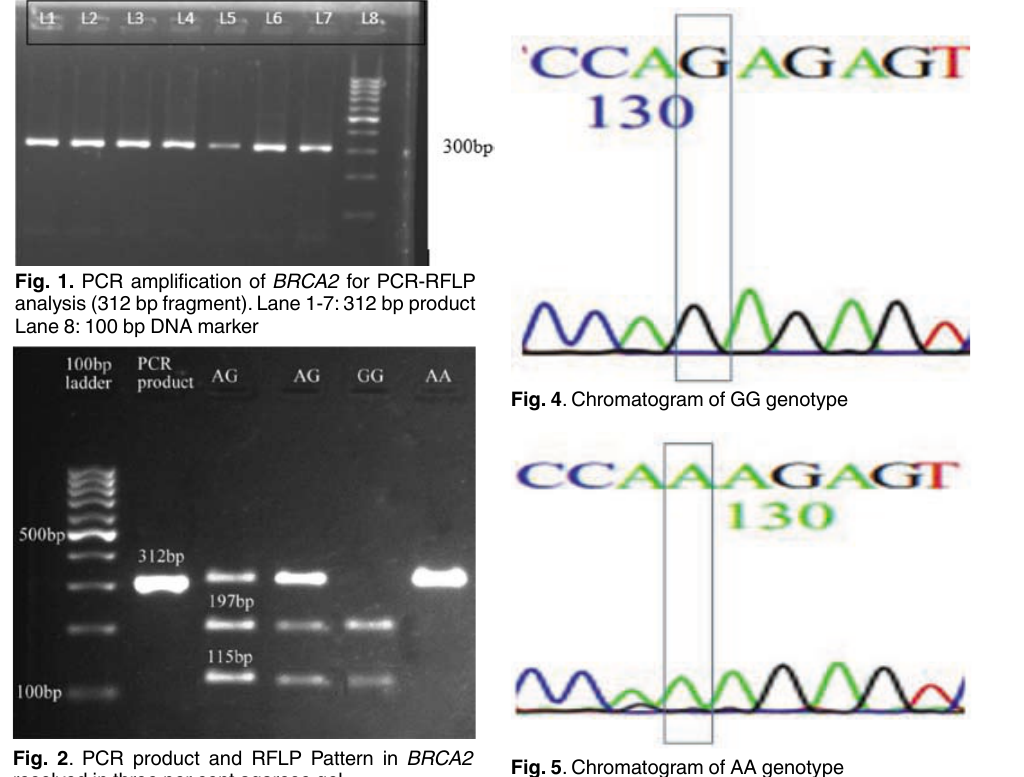
Fig. 5 . Chromatogram of AA genotype